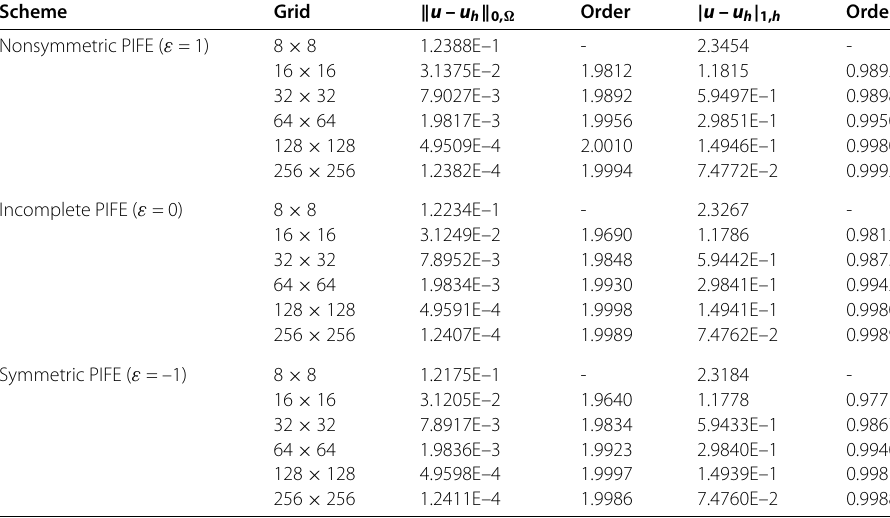
Table 3 Numerical results for B + = [1,2;2,5], B – = [10,20;20,50]